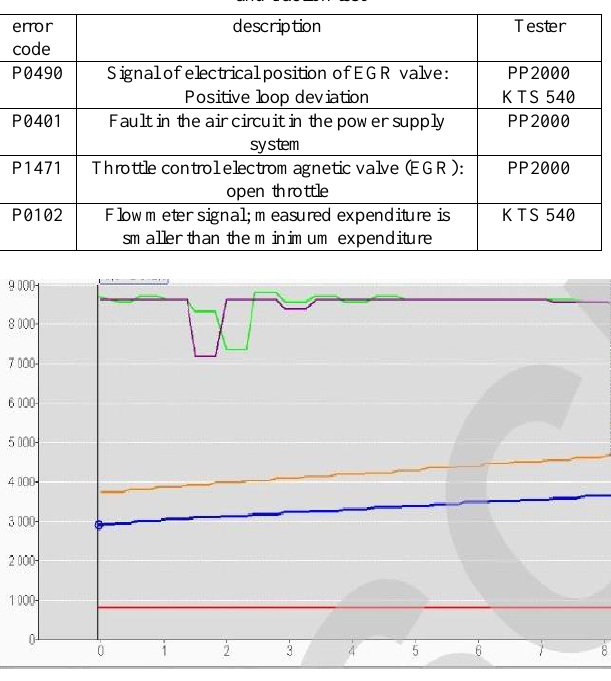
Fig. 1. Record of real parameters during the test as a function of time (s). Markings: boost pressure required – purple line, boost pressure measured – green line, travel speed – yellow line and engine speed – blue line (max. Test 102 km/h at 2300 1/min), red line – EGR valve positioning